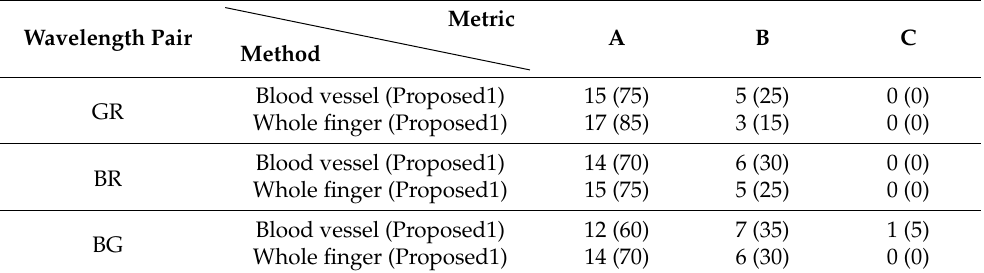
Table A2. EGA-based comparison of HbA1c estimation for different wavelength